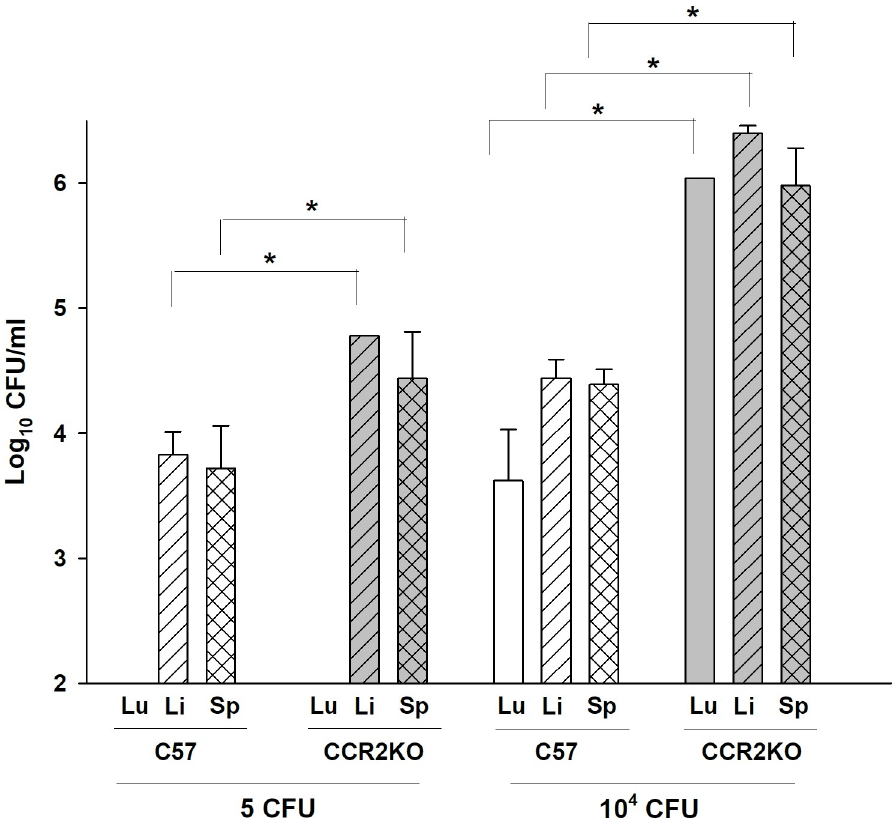
Fig 2. CCR2 KO mice exhibit increased bacterial burdens in organs following ID LVS infection with 10 4 LVS. C57BL/6J or CCR2 KO mice were infected ID with 5 or 10 4 CFU of LVS. Three mice per group were sacrificed at day 6 after infection, and lungs (open bars), livers (hatched bars), and spleens (cross hatched bars) were harvested, homogenized, and plated on MH plates to enumerate CFU. Each bar represents the average ± standard deviation of three samples from the indicated mice using the stated dose. Results are shown from one representative experiment of three of similar design and outcome. � p � 0.05 by Student’s t test between the bracketed comparisons between each type of organ at each